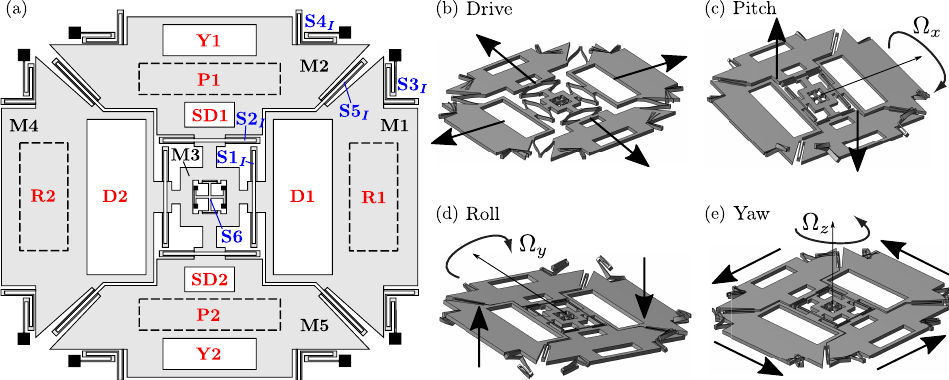
Figure 2. Reference layout of a triaxial beating heart MEMS gyroscope ( a ) and associated modal shapes: drive ( b ), sense pitch ( c ), sense roll ( d ), and sense yaw ( e ) modes. Redrawn from